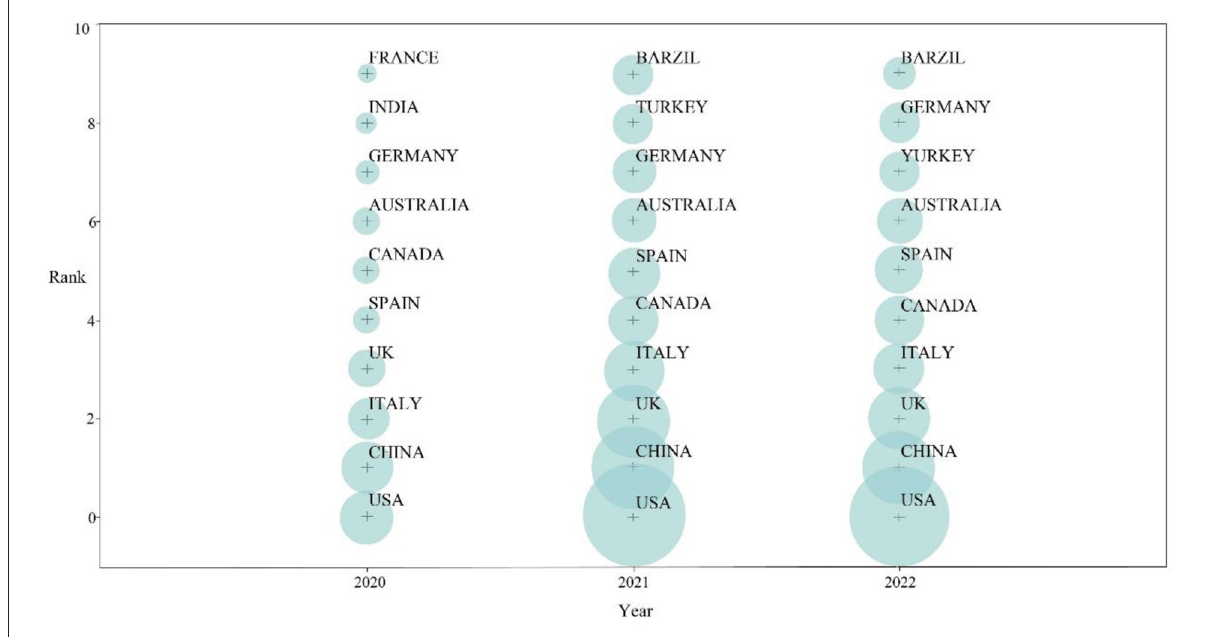
FIGURE3 Top 10 countries with the highest number of publications from 2020 to 2022.